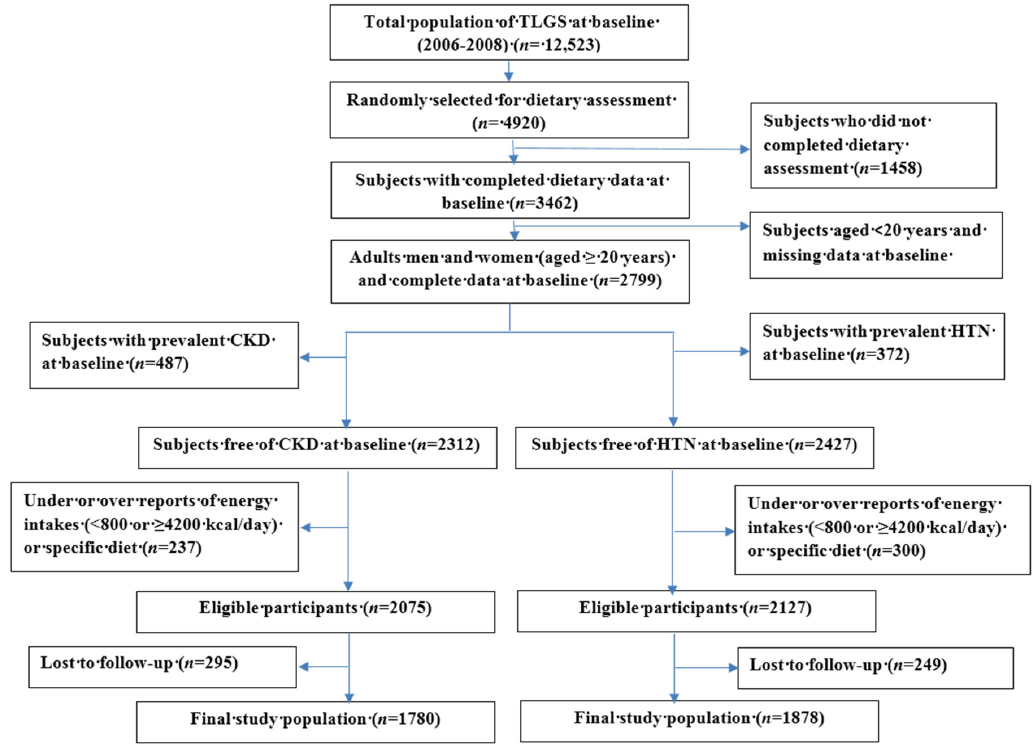
Figure 1. Flowchart of the study population, Tehran Lipid and Glucose Study (2006–2008 to 2012– 2014).